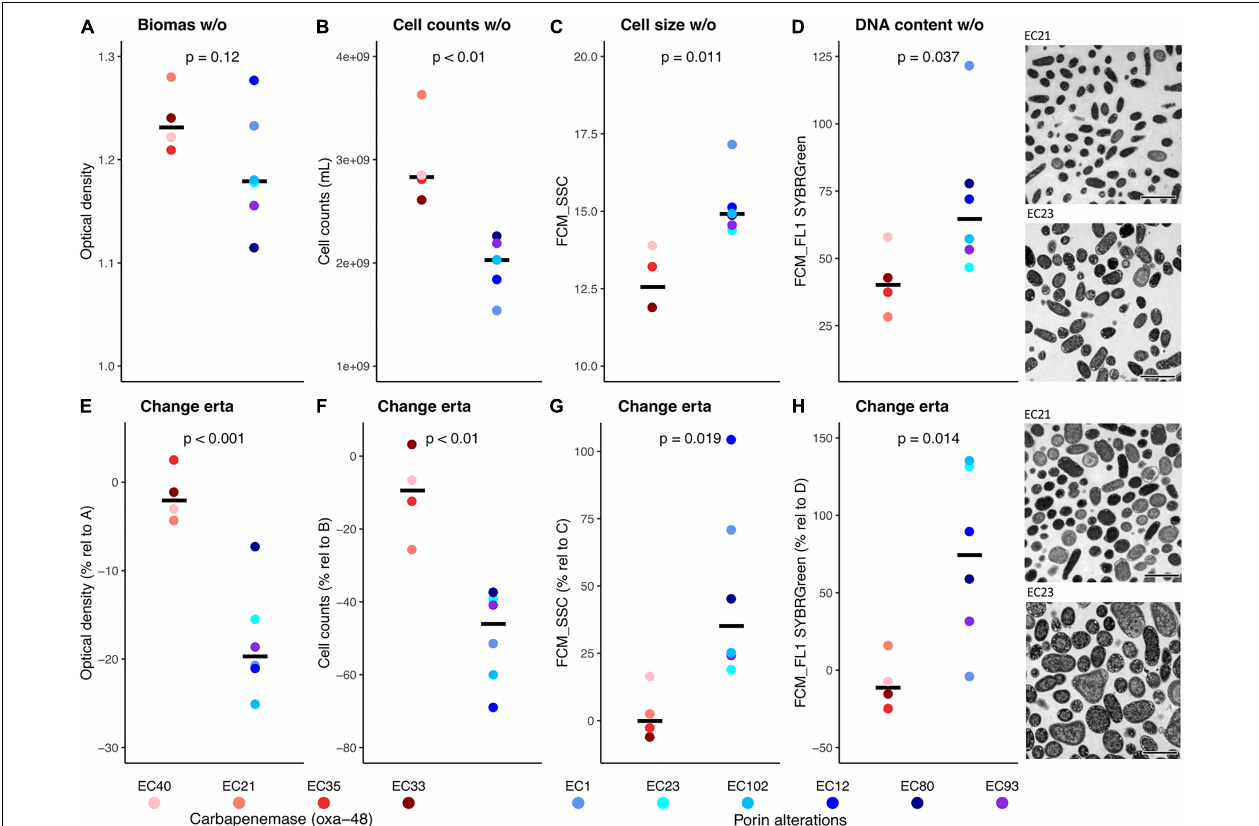
FIGURE 2 | Results of basic growth parameters of strains of the two groups determined during steady-state growth in continuous culture are shown. The upper row (panels A–D ) displays results during growth without carbapenem (w/o). (A) biomass (OD measurements), (B) cell concentrations [based on flow cytometric measurements (FCM)], (C) relative cell size (based on FCM sideward scatter signals; values of EC21 and EC33 are very similar and undistinguishable on the plot), (D) relative DNA content (based on FCM green fluorescence signals). The lower row (panels E–H ) displays results during growth with sublethal concentrations of carbapenem (0.5 mg L − 1 ertapenem; erta) relative to growth without the antibiotic. Results of statistical testing (Student’s t -test) between groups are indicated. Transmission electron microscopy pictures of representative strains of each group during growth in both conditions ( + / − ertapenem) are shown on the right. The scale bar represents 2 µ